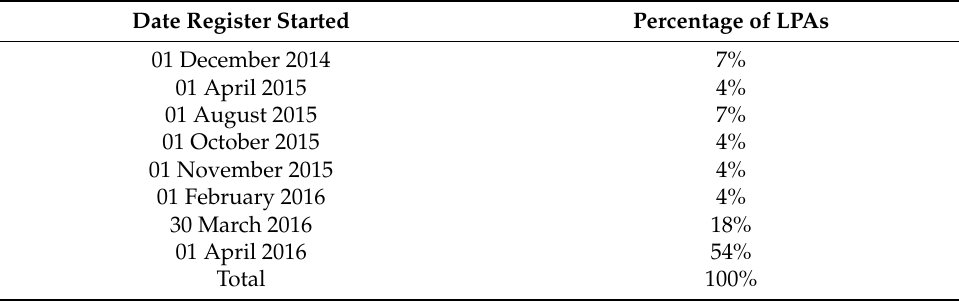
Table 4. Dates LPAs implemented their Registers.